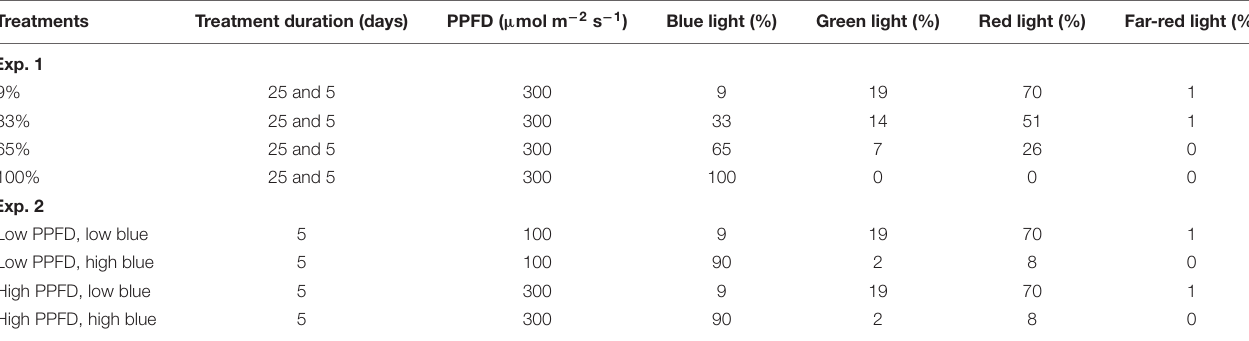
TABLE 1 | Photosynthetic photon flux density (PPFD) (400–700 nm) and spectra of the treatments for Experiments 1 and 2. Treatments Treatment duration